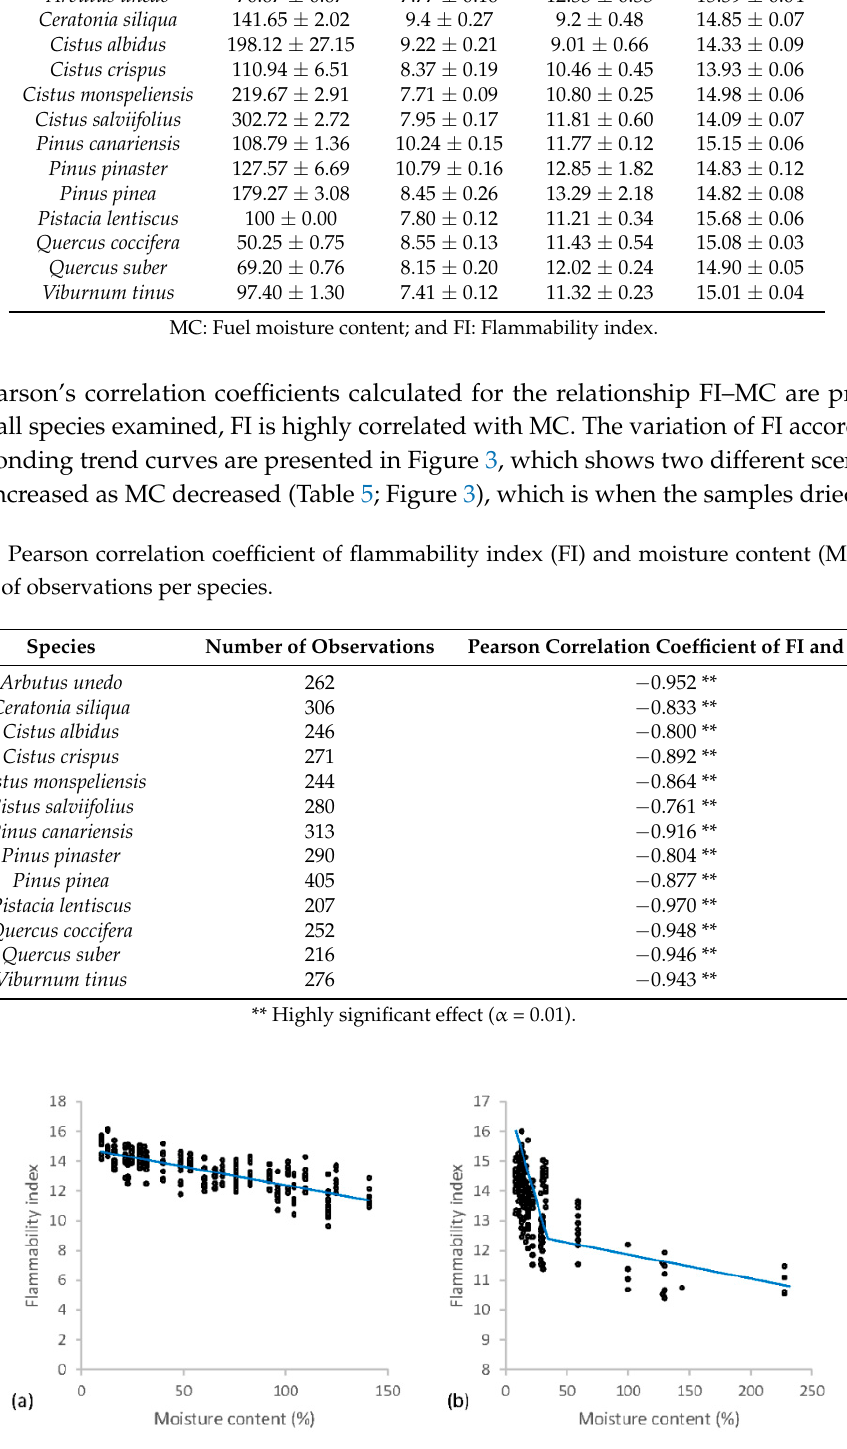
Table 4. Average values of the flammability indices calculated based on Equation (3) per species for fresh and dried samples and their respective average MC-values followed by standard errors.